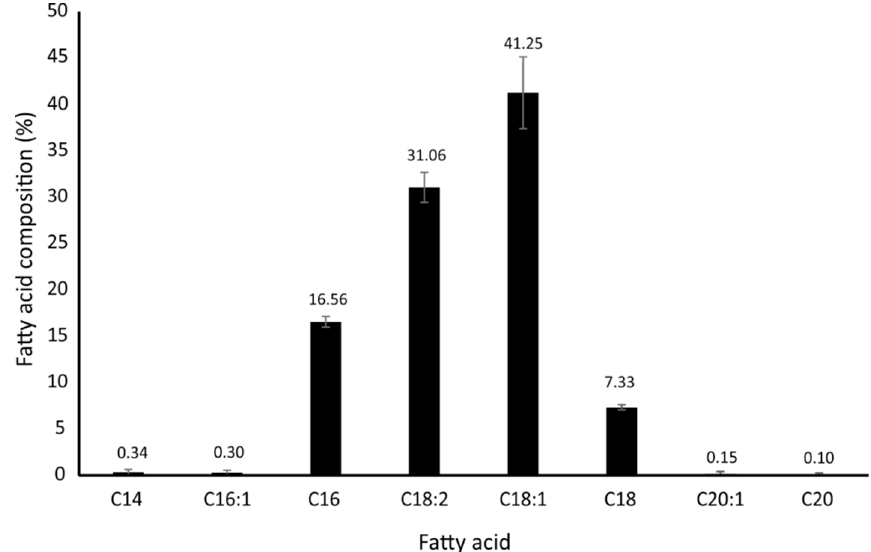
Figure 1. Fatty acid composition (expressed as a % of total fatty acids present) of hydrolysed waste cooking oil (HWCO) analysed by GC/MS. C14—myristic acid; C16:1—palmitoleic acid; C16—palmitic acid; C18:2—linolelaidic acid; C18:1—oleic acid; C18—stearic acid; C20:1—gondoic acid; and C20—arachidic acid. The error bar represents standard deviation among three separate hydrolysis experiments.